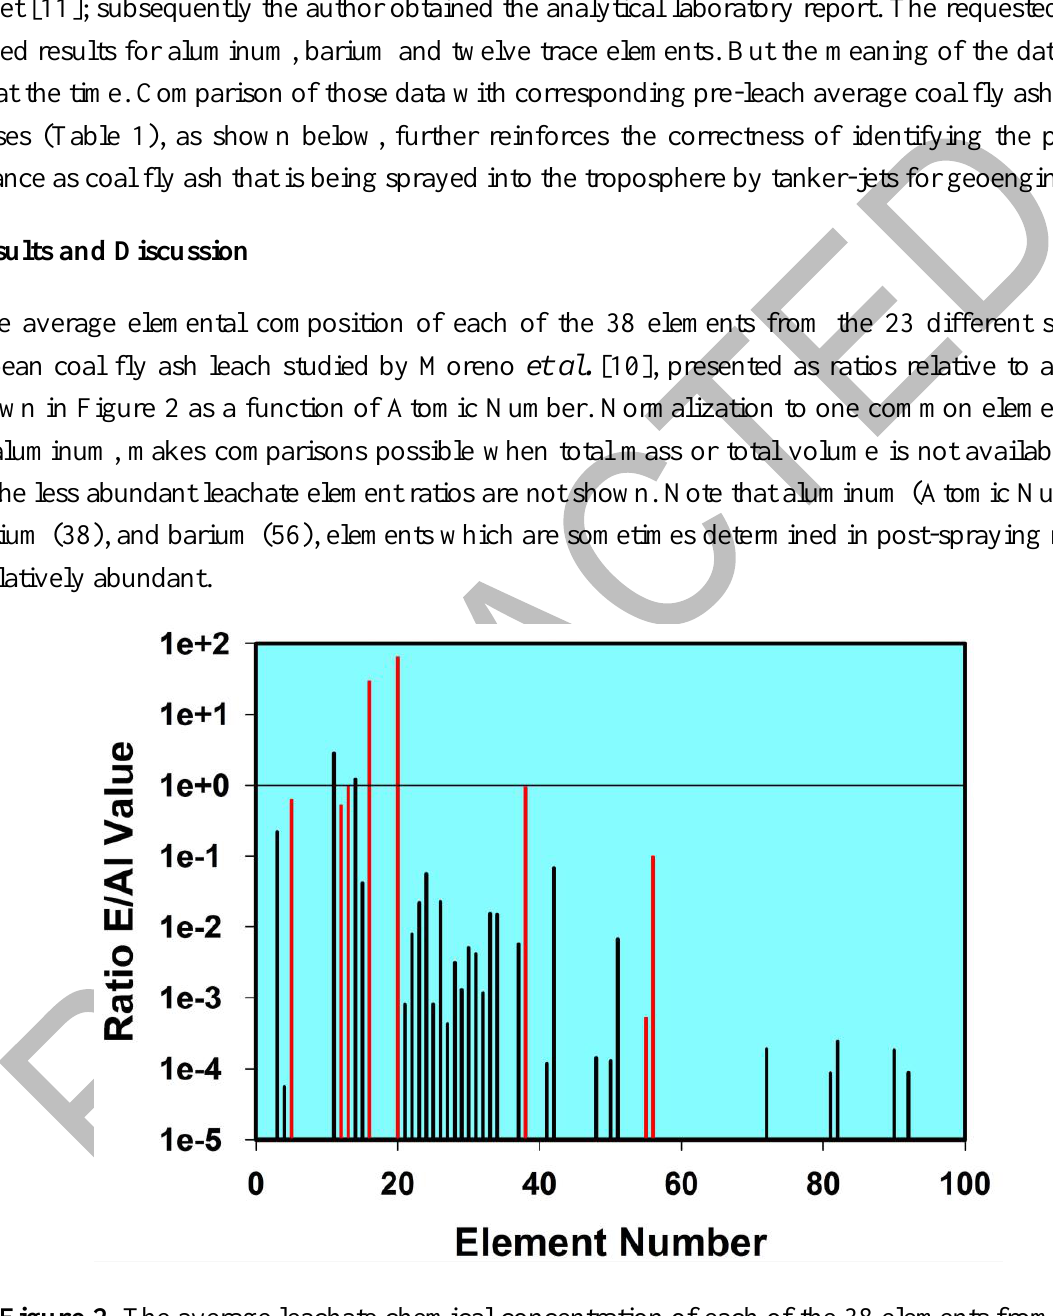
Figure 2. The average leachate chemical concentration of each of the 38 elements from the 23 different sources of European coal fly ash (Table 1) studied by [10], normalized to aluminum so as to facilitate comparison with analyzed post-aerosol-spraying rainwater. Elements of lower concentration are not shown. Red leachate elements correspond to those measured in San Diego rainwater (Figure 3), from left to right, Boron, Magnesium, Aluminum, Sulfur, Calcium, Iron, Strontium and